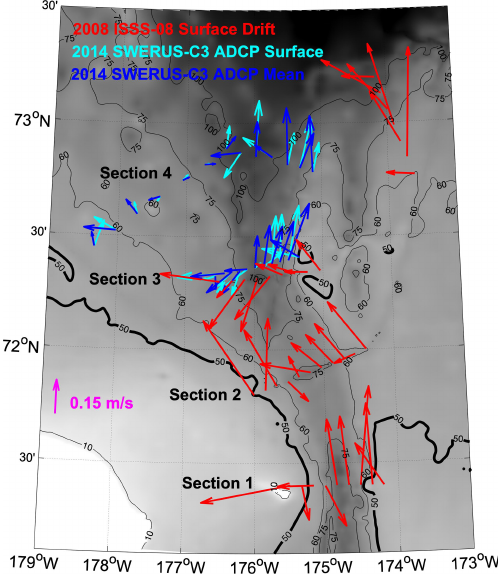
Figure 2. Circulation pattern in Herald Canyon and refer- ence velocities for the geostrophic shear velocities. Shown are 2014 SWERUS-C3 vertical mean LADCP velocities (blue arrows), 2014 SWERUS-C3 surface LADCP velocities (cyan arrows), and 2008 ISSS-08 surface velocities from ship drift and navigation data (red arrows). Bathymetry (grey-scale shading and black contours) is from the International Bathymetric Chart of the Arctic Ocean (IB- CAO) version 4 (Jakobsson et al.,